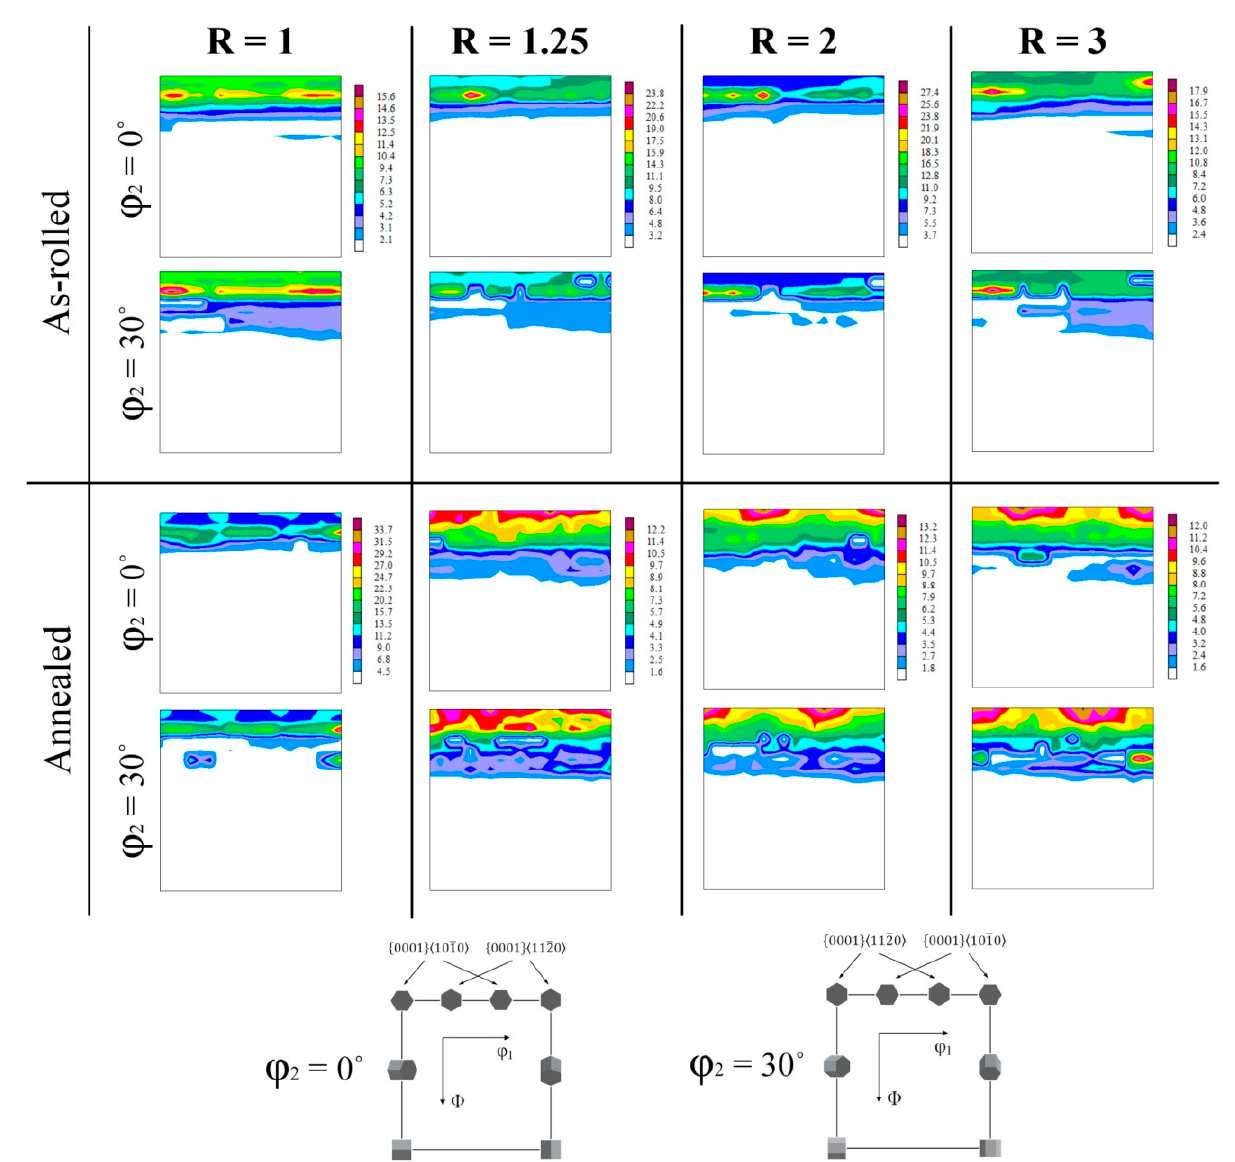
Figure 7. The orientation distribution functions (ODFs) ( ϕ 2 = 0° and 30° sections) of the as-rolled and annealed Mg-6Sn sheets processed with different speed ratio (R) obtained from XRD measurements on the RD-TD plane.